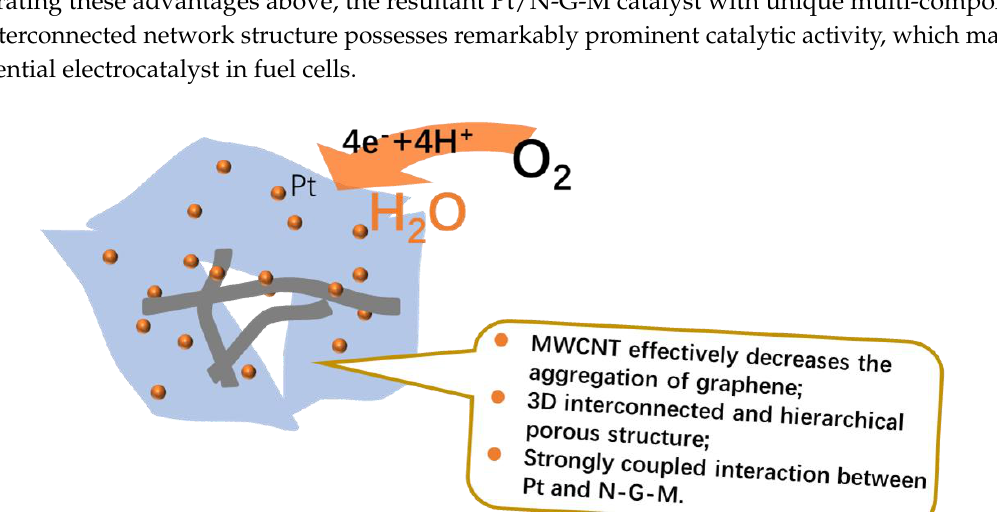
Figure S1: SEM images (a,b) and TEM images (c,d) of GO-MWCNT. Figure S2: The pore size distributions of G, G-M, and N-G-M supports. Figure S3: TEM images for (a) JM20 and (c) Pt/M catalysts. The corresponding particle size distribution curves for (b) JM20 and (d) Pt/M catalysts. Figure S4: Low magnification TEM images for (a) Pt/G, (b) Pt/G-M, and (c) Pt/N-G-M catalysts. Figure S5: Nyquist plots of EIS for JM20, Pt/G, Pt/G-M, and Pt/N-G-M recorded in 0.1 M HClO4. Figure S6: ORR polarization curves for JM20 and Pt/N-G-M catalysts in 0.1 M HClO 4 + 0.1 M CH 3 OH with a potential scan rate of 5 mV · s − 1 . Table S1: Results of the fits of Pt 4f spectra, values given in percentage of total intensity.